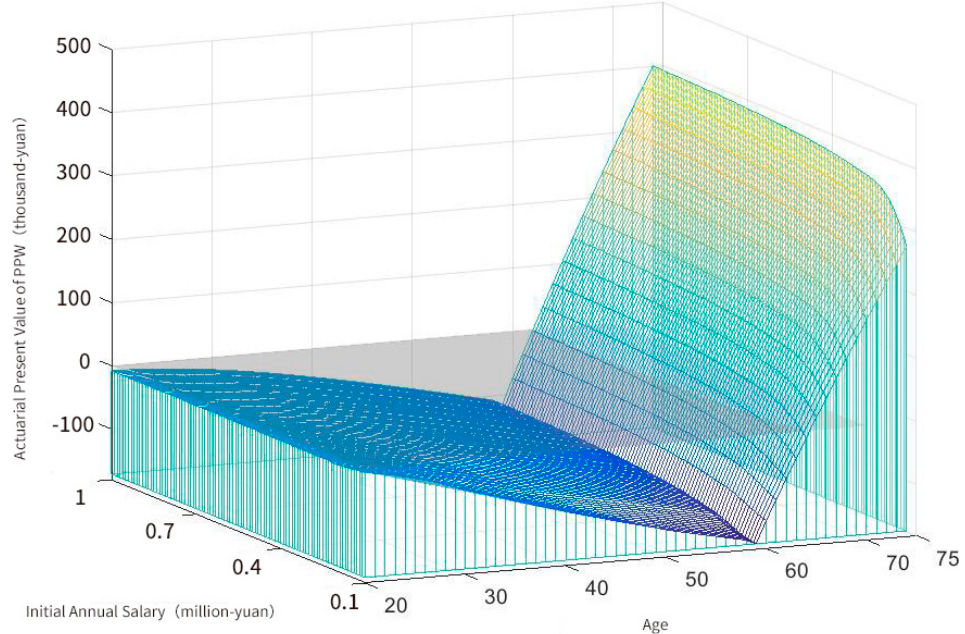
Figure 6. The impact of different initial annual salaries of 20-year-old insured men on the present value of PPW.